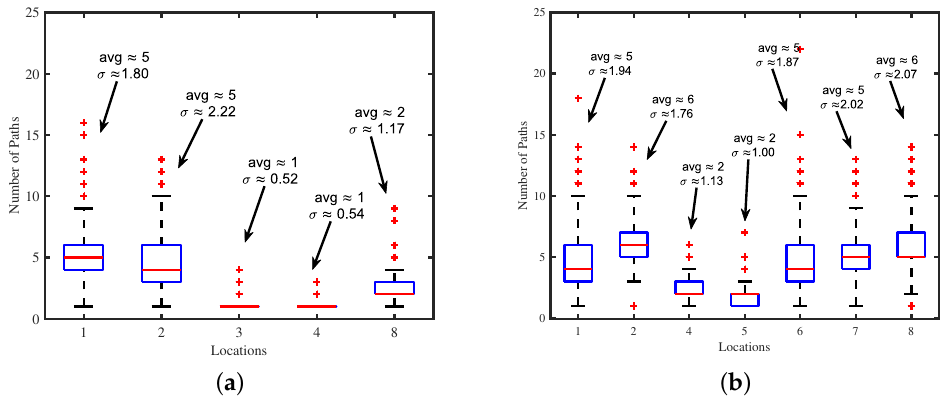
Figure 5. Box plot for the number of paths for Op1 and Op2 at all measurement locations, showing median value (red line), standard deviation (blue box), and outliers (red plus signs). ( a ) Op1 ( b ) Op2. Interarrival time, defined as the time difference between two consecutive paths, is also a parameter of interest. Interarrival time is a random variable that depends on the wireless channel conditions. The interarrival times vary with environment, surroundings, and